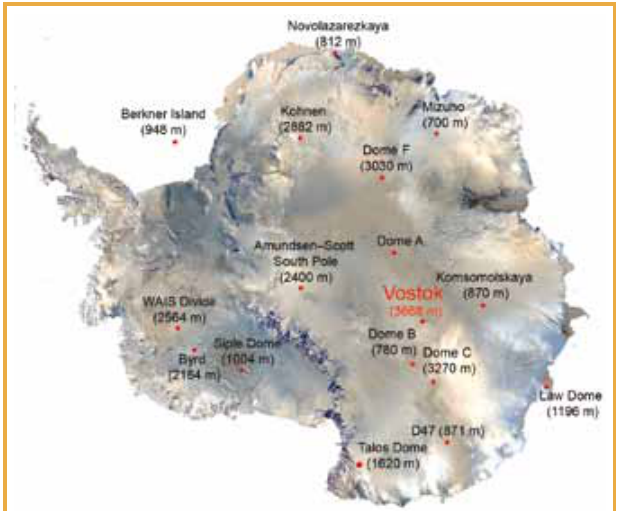
Figure 1. Vostok station and other deep ice coring sites on